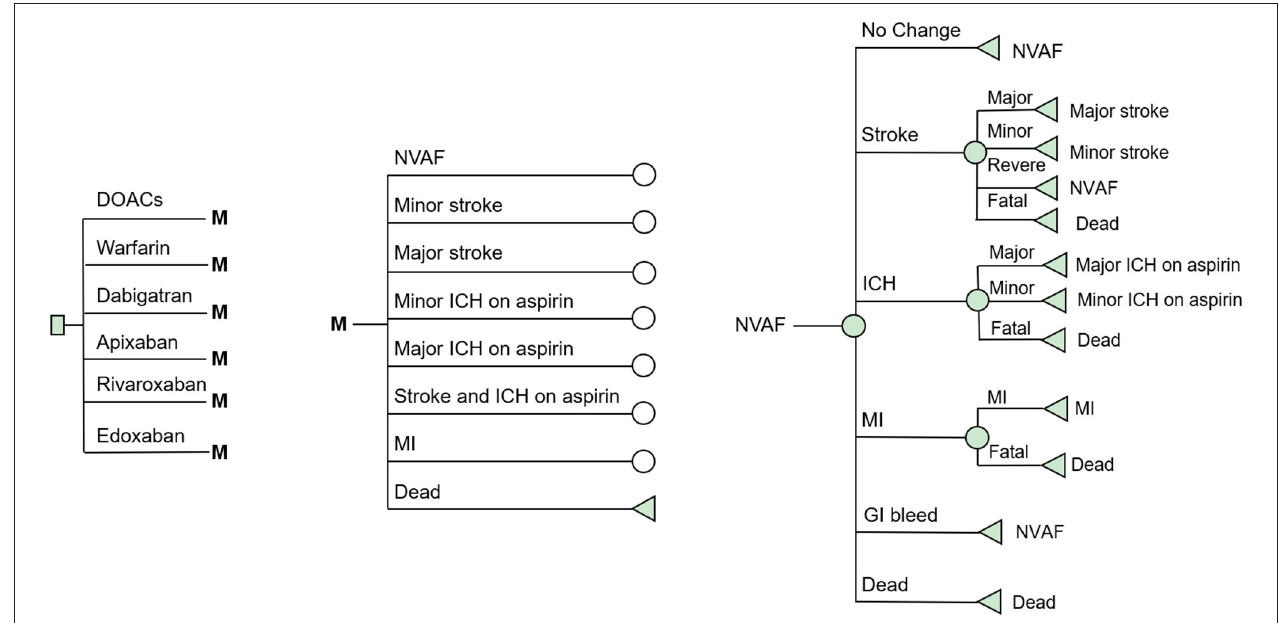
FIGURE 1 | Schematic representation of the Markov model. AF, atrial fibrillation; Stroke, ischemic or hemorrhagic stroke; SE, systemic embolism; GI Bleeding, gastrointestinal bleeding; ICH, intracranial hemorrhage; MI, myocardial